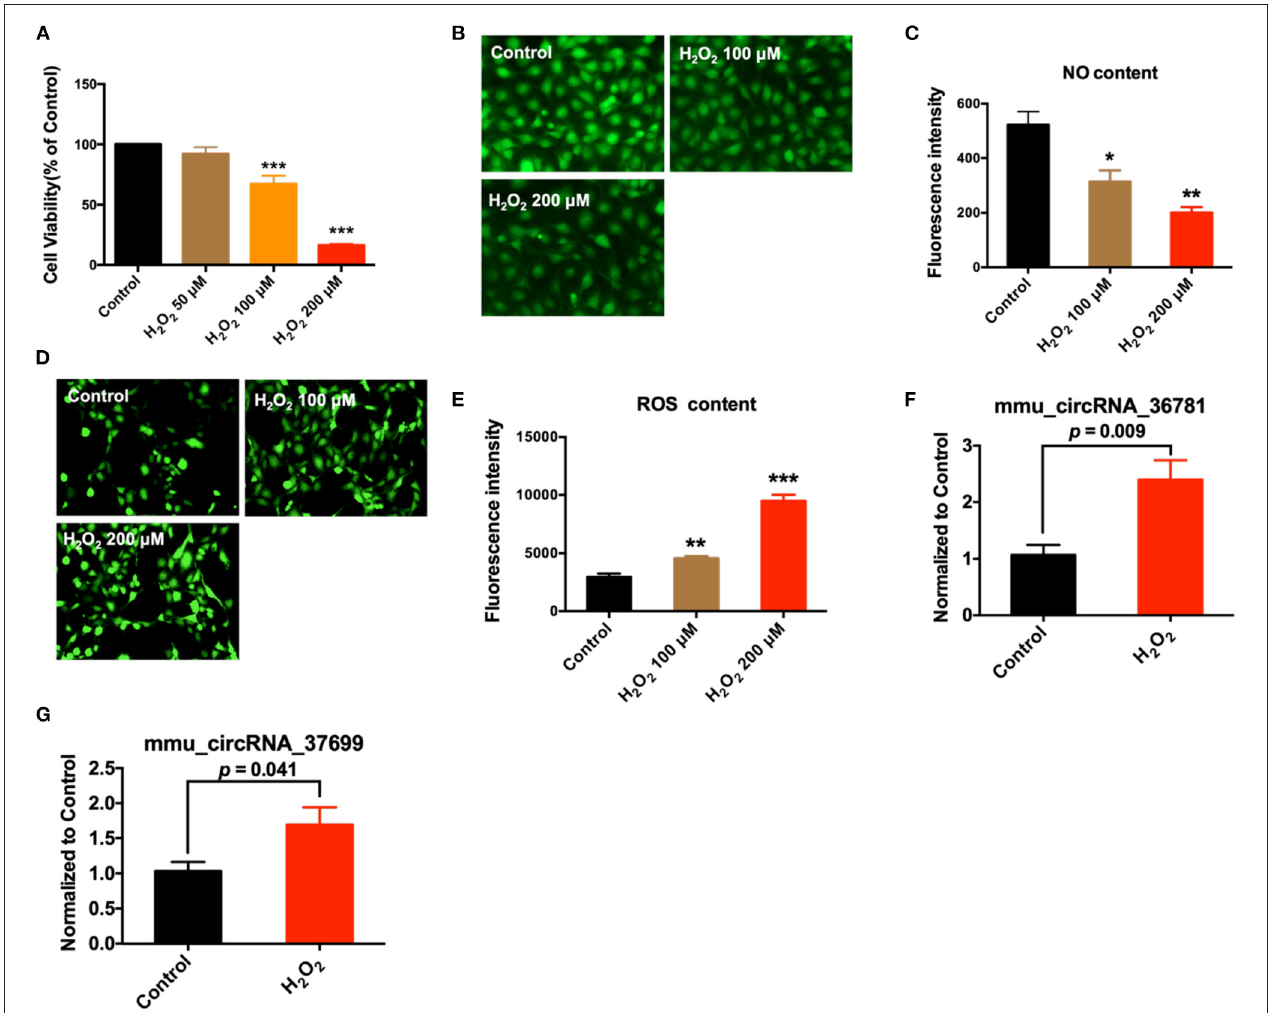
FIGURE 4 | Validation of differentially expressed circRNAs in MAECs induced by H 2 O 2 . (A) Effect of H 2 O 2 on cell viability; *** P < 0.001 vs. Control, n = 4. (B,C) Effect of H 2 O 2 on NO concentration of MAECs; 400 × , n = 3. * P < 0.05, ** P < 0.01 vs. Control. (D,E) Effect of H 2 O 2 on ROS concentration of MAECs; 400 × , n = 3. ** P < 0.01, *** P < 0.001 vs. Control. (F,G) Expression of mmu_circRNA_36781 and mmu_circRNA_37699 in MAECs induced by 100 µ M H 2 O 2 , n =